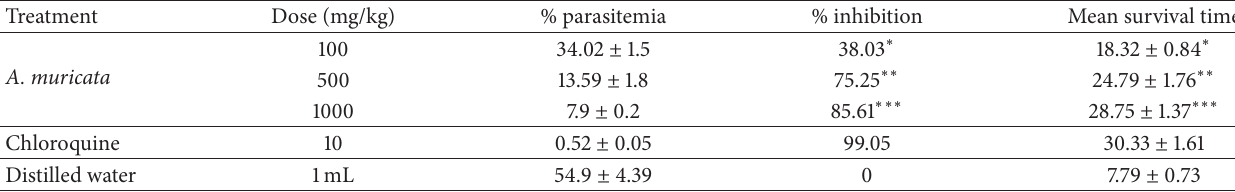
Table 1: Effect of A. muricata aqueous leaf extract on parasitemia and mean survival time.